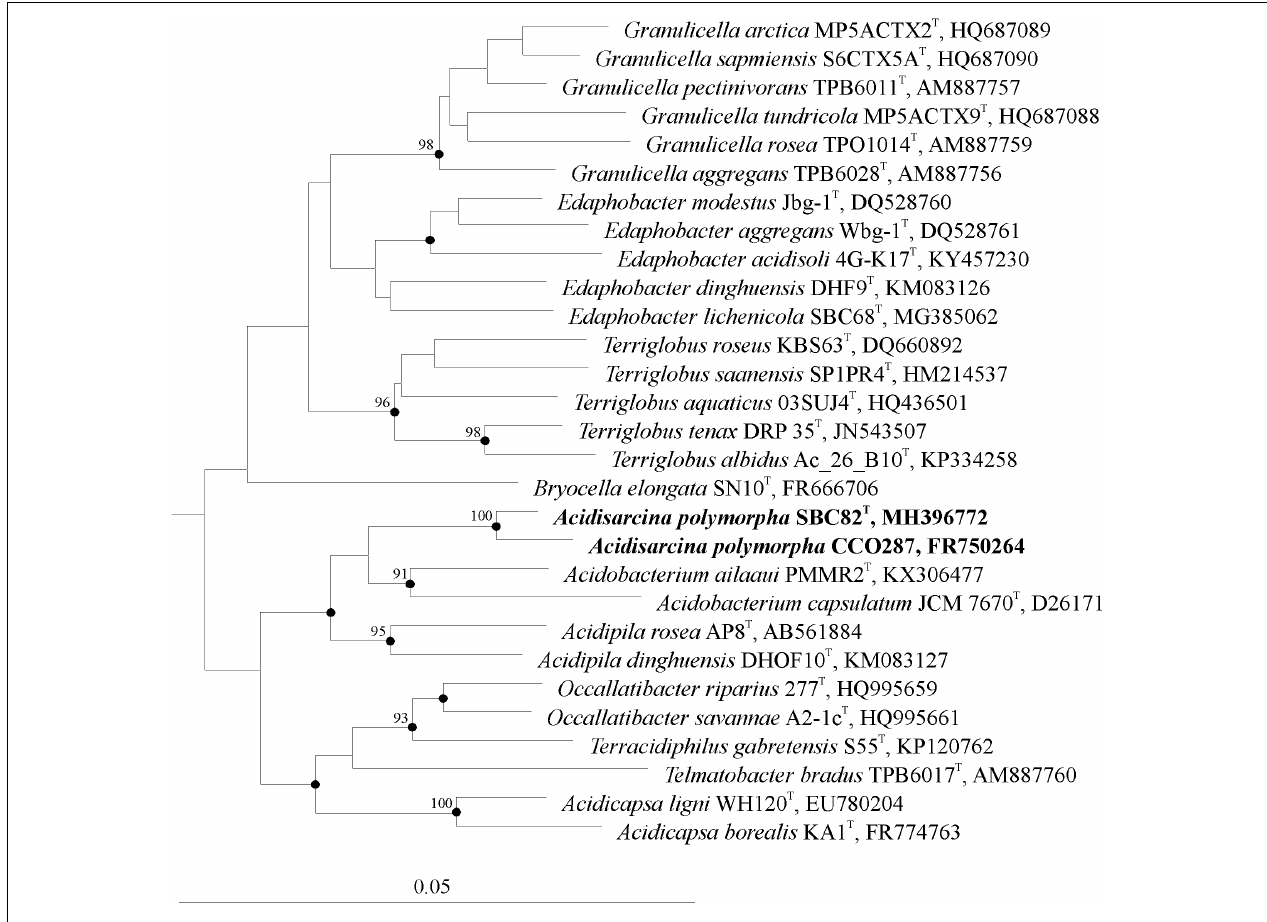
FIGURE 3 | Unrooted 16S rRNA gene-based neighbor-joining tree showing the phylogenetic relationship of strains SBC82 T and CCO287 to representative members of the family Acidobacteriaceae. The tree was calculated based on 1,380 nt positions using the ARB program package (Ludwig et al., 2004). The significance levels of interior branch points obtained in the neighbor-joining analysis were determined by bootstrap analysis (based on 1,000 data resamplings) using PHYLIP (Felsenstein, 1989). Bootstrap values of > 90% are shown. Black circles indicate that the corresponding nodes were also recovered in the maximum-likelihood and maximum-parsimony trees. Bar, 0.05 substitutions per nucleotide position.